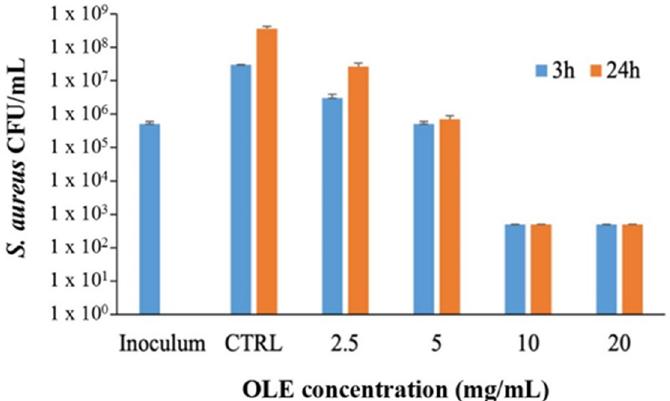
Figure 1. Antibacterial activity of OLE against S. aureus ATCC 33591 after 3 and 24 h of incubation in 5% TSB. Control (CTRL) represents bacteria incubated in the absence of OLE. Bactericidal activity was defined as a reduction in the numbers of viable bacteria of ≥ 3-log colony forming units (CFU)/mL at any incubation time tested. Data are reported as mean ± SD ( n = 3).